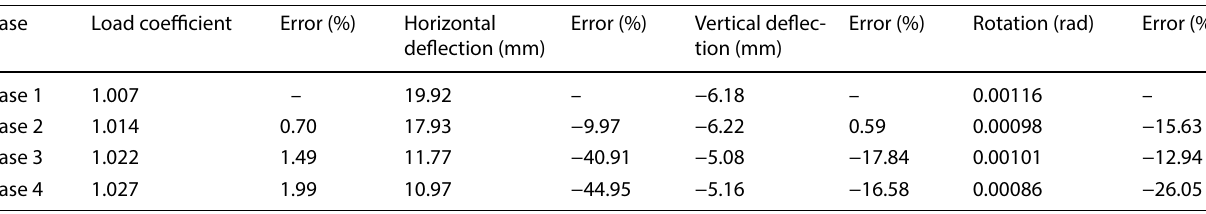
Case 1 considers both shear deformation and residual stress; Case 2 considers only residual stress; Case 3 considers only shear deformation; Case 4 does not consider both shear deformation and